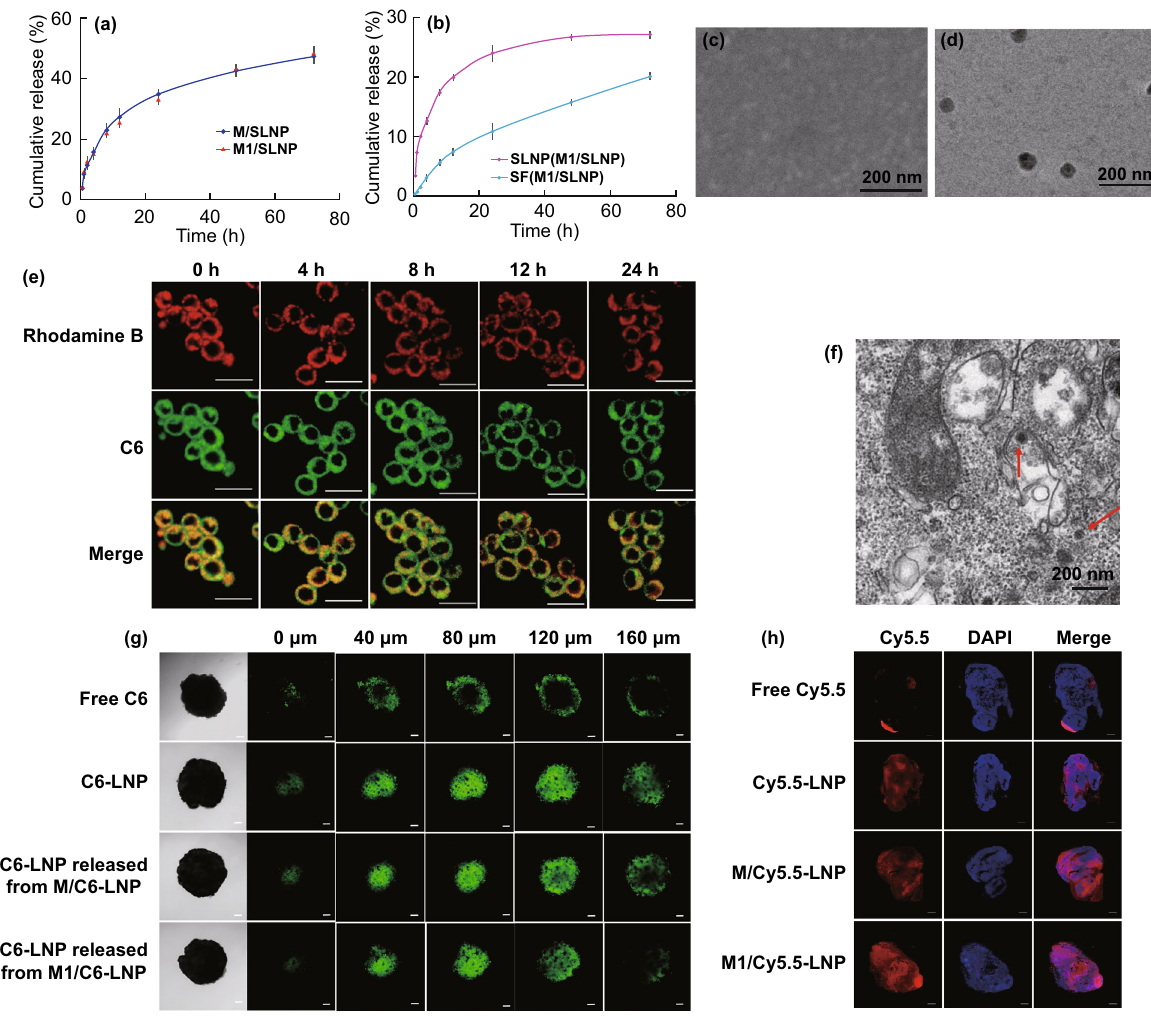
Fig. 2 SLNP could be released from M1/SLNP and exhibited deep tumor-penetrating ability. a Release profiles of total SF from M/SLNP and M1/SLNP. b Release profiles of SF or SLNP from M1/SLNP, respectively. TEM images of released medium from c M1-type macrophages or d M1/SLNP. Scale bar: 200 nm. e CLSM images of M1/C6-LNP at 0, 4, 8, 12, and 24 h. Scale bar: 20 μm. f TEM images of M1/SLNP at 24 h. Scale bar: 200 nm. Red arrow indicated SLNP. g Penetration of M1/SLNP into tumor spheroids after incubation for 6 h. Scale bar: 100 μm. h Tumor sections of mice 24 h after injection of M1/Cy5.5-LNP, M/Cy5.5-LNP, Cy5.5-LNP and free Cy5.5, respectively, in vivo. Scale bar: 1000